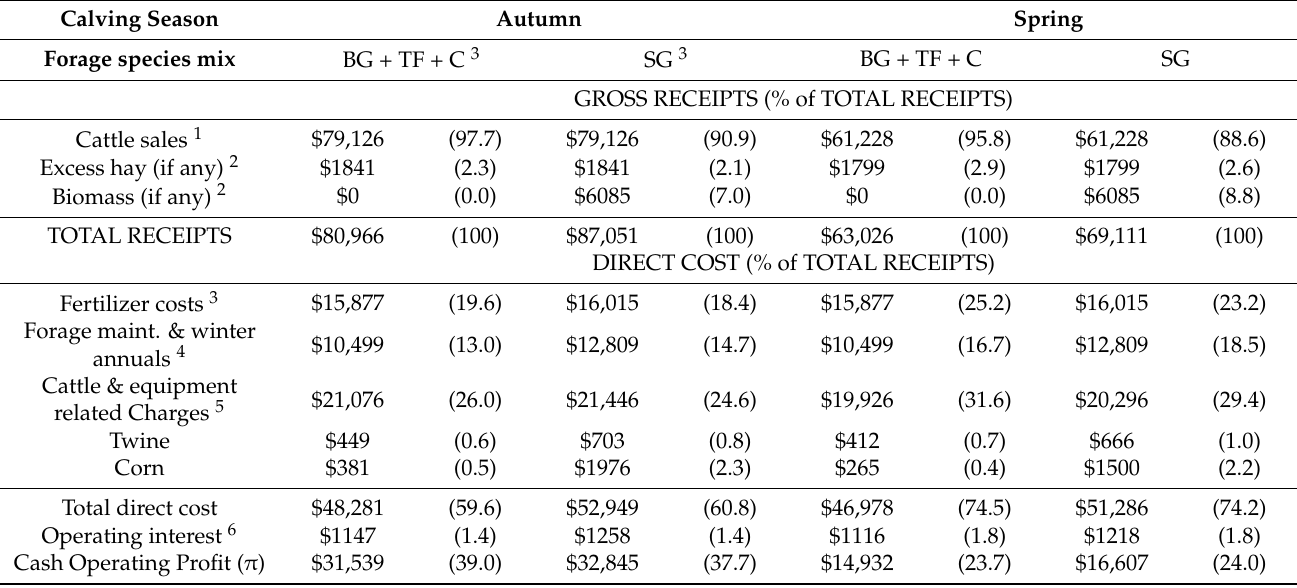
Table 6. Estimated revenue and direct costs of a 96-cow herd by calving season and forage species mix at $50 Mg − 1 for